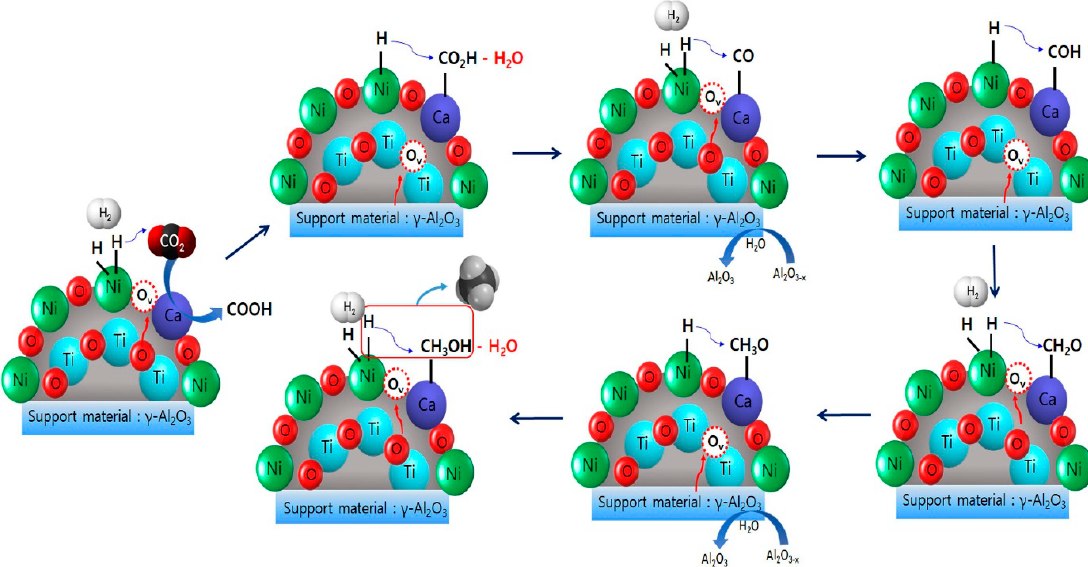
Figure 6. Plausible mechanism for CO 2 methanation over the Ca-NiTiO 3 / γ -Al 2 O 3 catalysts. Reproduced with permission from ref. [84]. Copyright 2020 Elsevier.